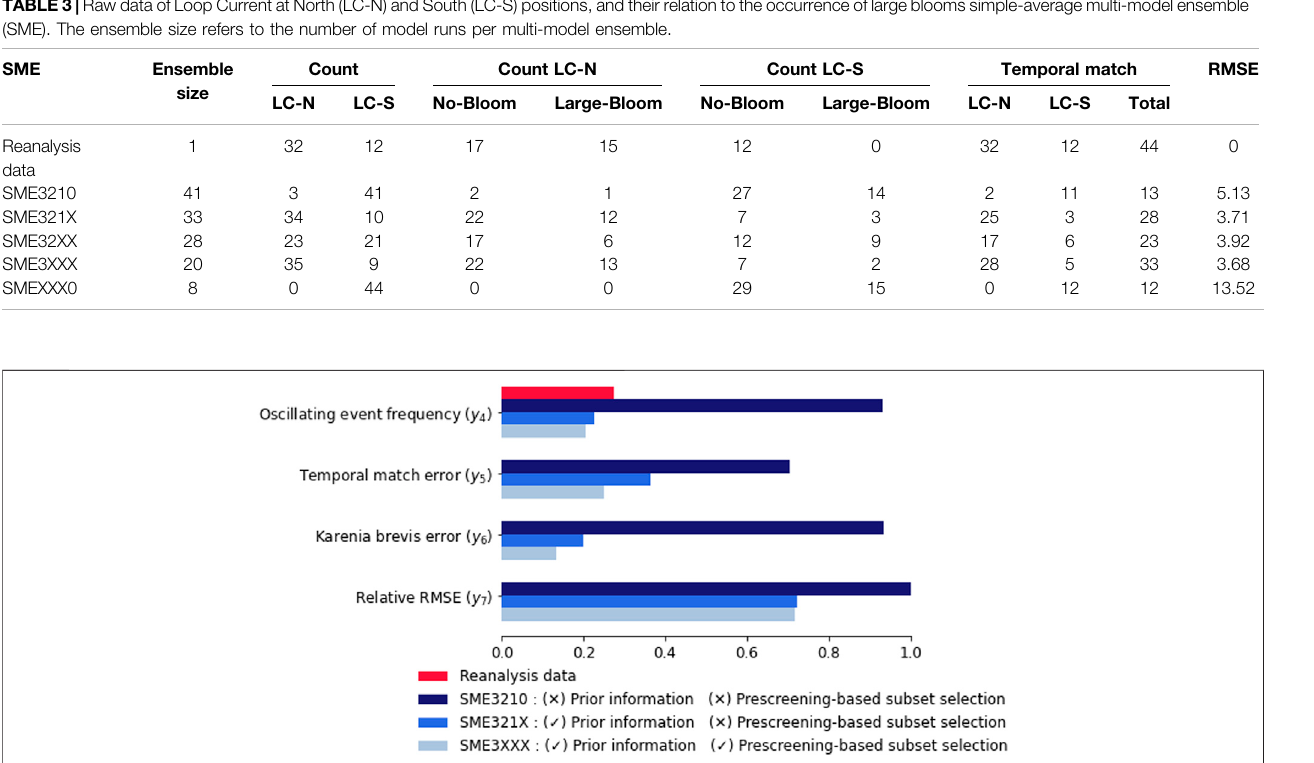
FIGURE 7 | Predictive performance ( y 4 – y 7 ) given different ensemble composition